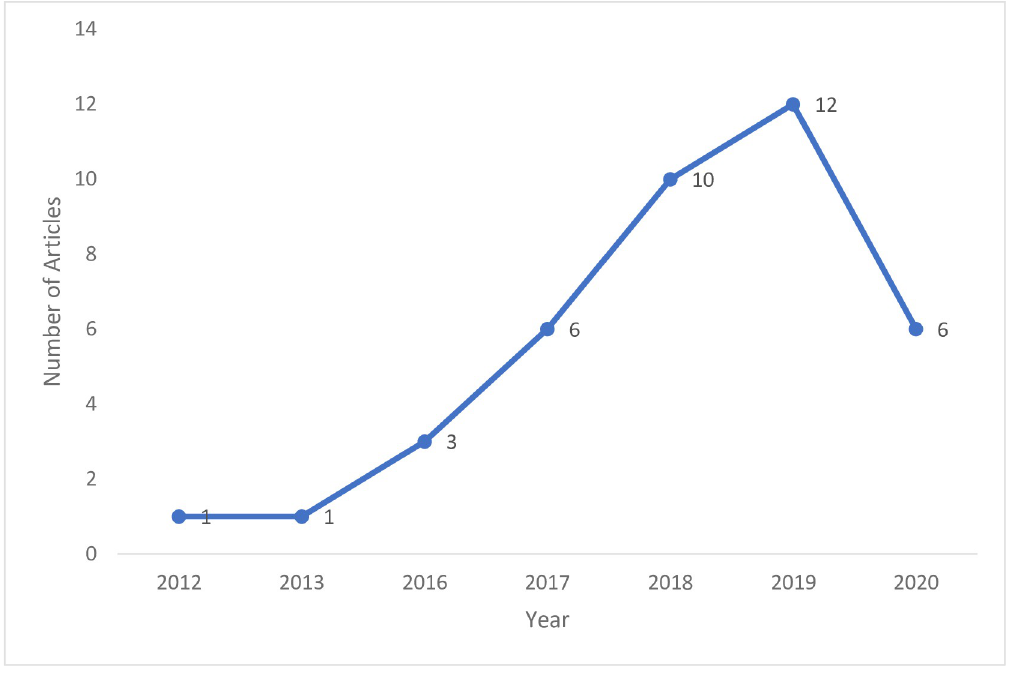
Fig 2. Line graph showing articles published per year (publication trends as of time of data collection).